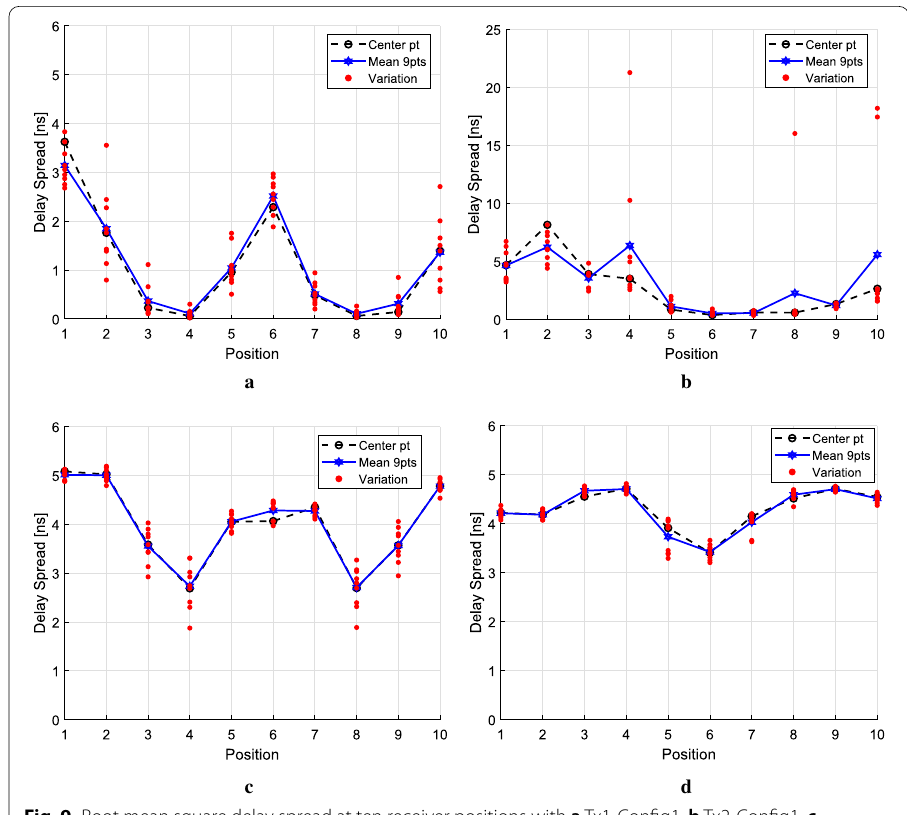
Fig. 9 Root mean square delay spread at ten receiver positions with a Tx1-Config1, b Tx2-Config1, c Tx1-Config2 and d